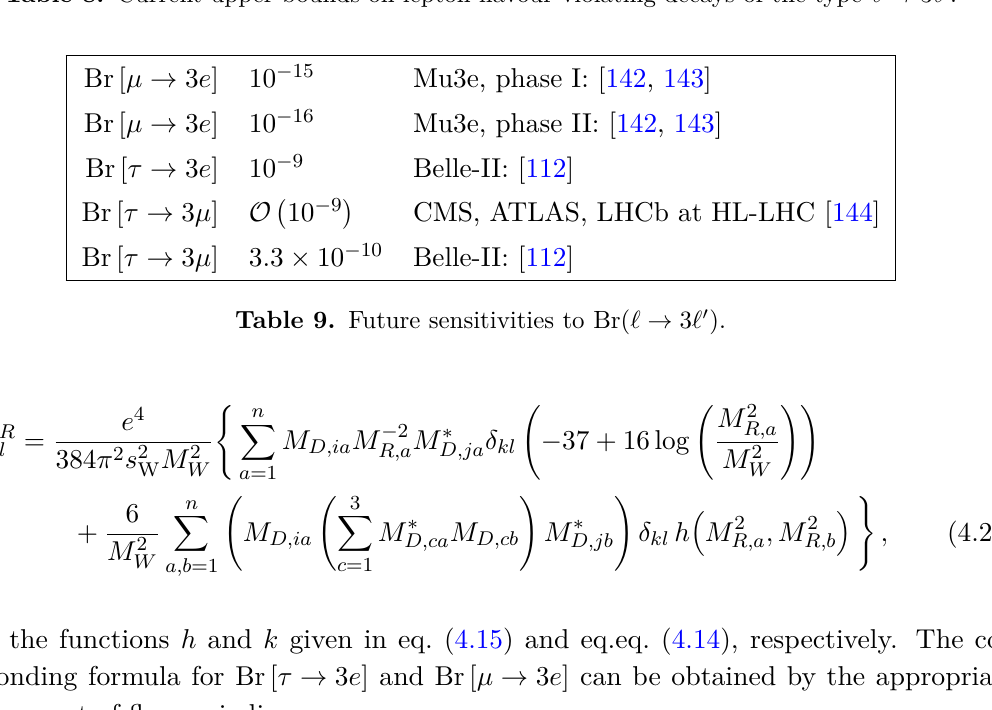
Table 8. Current upper bounds on lepton flavour violating decays of the type ‘ → 3 ‘ 0 .